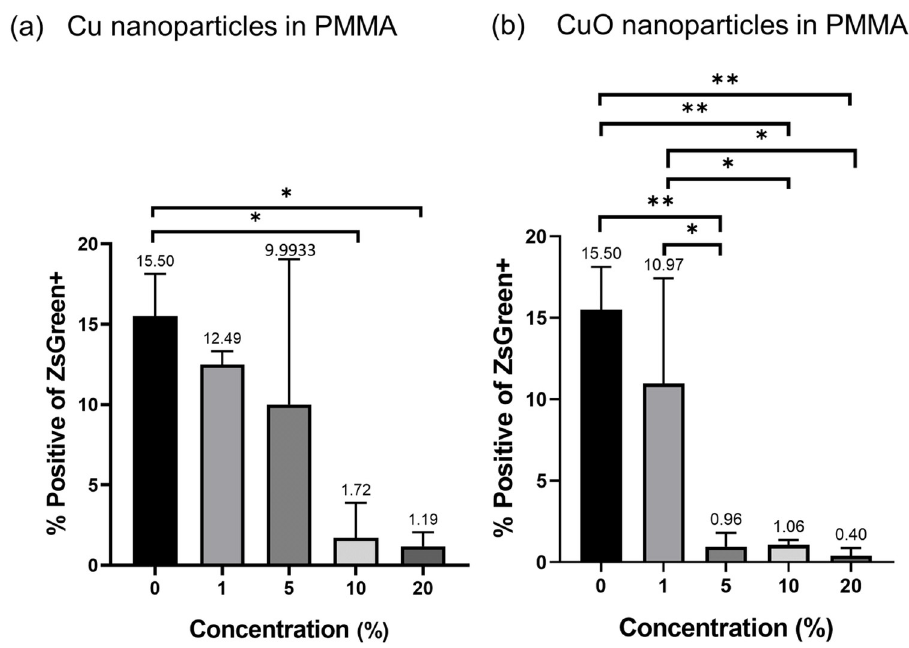
Fig 4. Level of positive of ZsGreen on samples with PMMA solutions (a) samples with different concentrations of copper nanoparticles (b) samples with different concentrations of copper oxide nanoparticles.